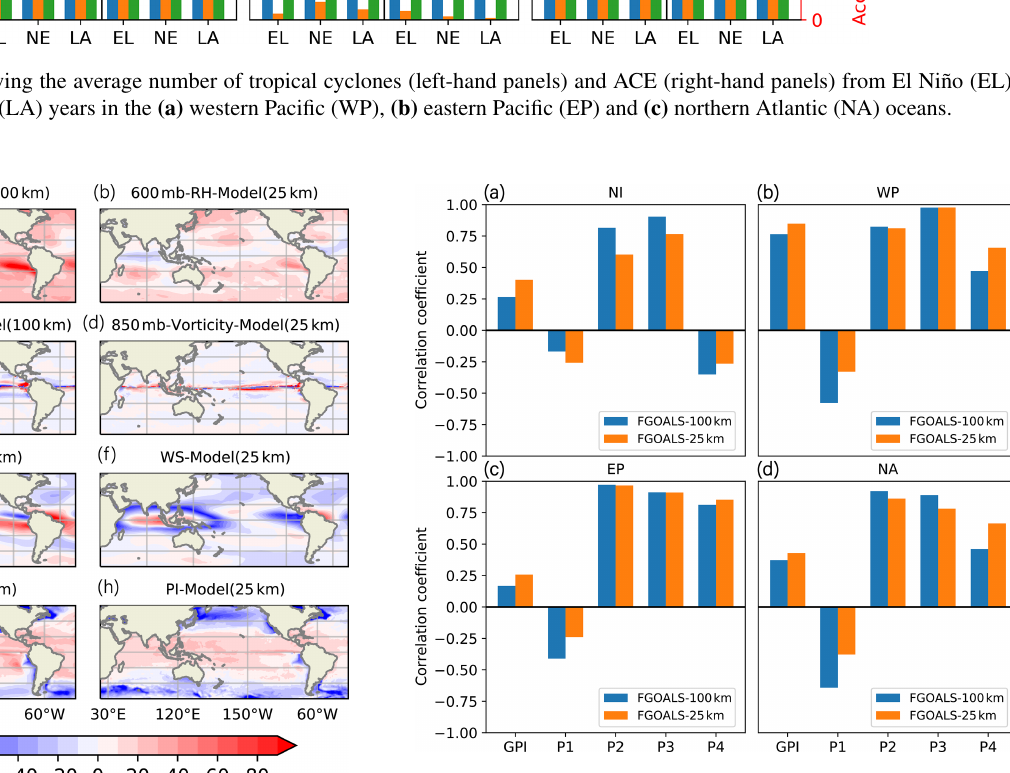
Figure 12. Pattern correlation of annual tropical cyclone GPI be- tween the ERA-Interim dataset and the simulation of FGOALS-f3 at low (blue bars) and high (orange bars) horizontal resolutions in the (a) northern Indian, (b) western Pacific, (c) eastern Pacific and (d) northern Atlantic oceans. P1–P4 represent parts 1–4 of Eq. (2). P1 represents the equation | 10 5 vort850 | 3 / 2 , P2 represents the equation RH , P3 represents the equation V m , and P4 represents the equation 50 70 ( 1 + 0 . 1 V shear ) − 2